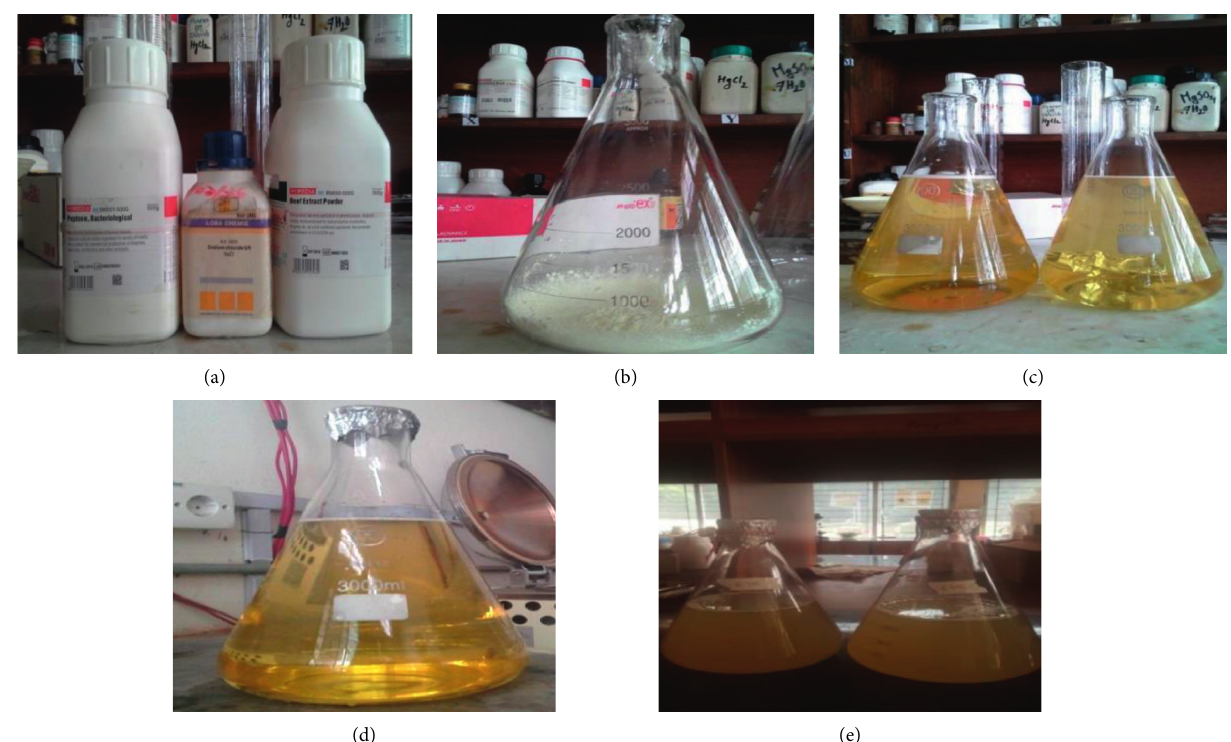
Figure 4: Preparation of the bacterial culture. (a) Materials. (b) Materials poured into flask for Luria–Bertani media. (c) Preparation of media for sterilization. (d) Media kept in refrigerator for germination. (e) Prepared bacterial